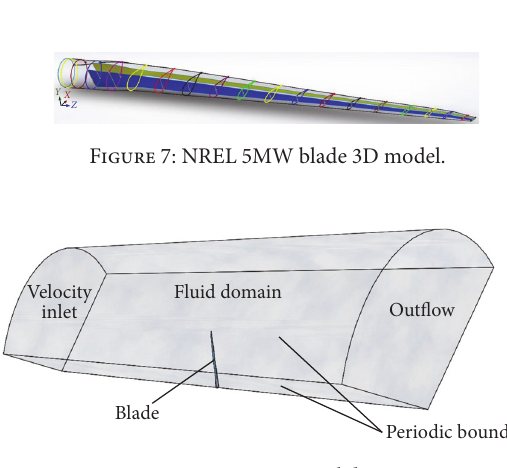
Figure 8: Computational domain.